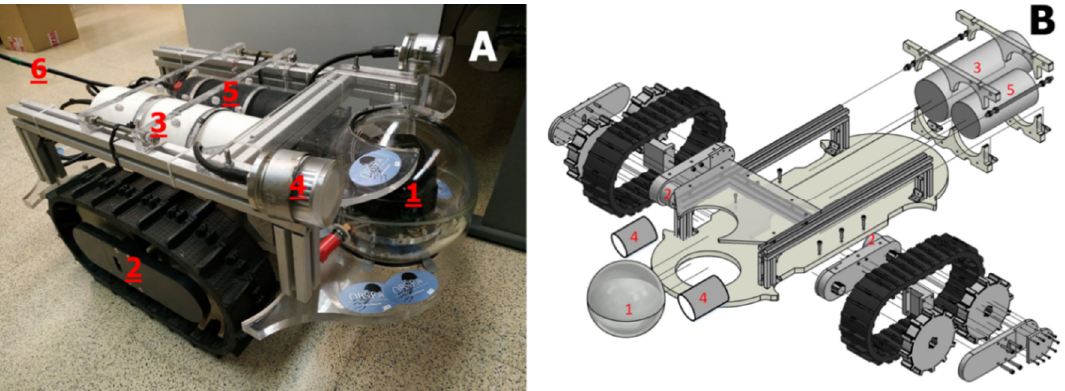
Figure 3. The crawler ( A ) and its components ( B ) with numbers indicating: (1) the camera dome, (2) the tracks, (3) the control cylinder for crawler functioning control, (4) lights, (5) the junction box, and finally, (6) the umbilical cable that connects the crawler to the seabed station.